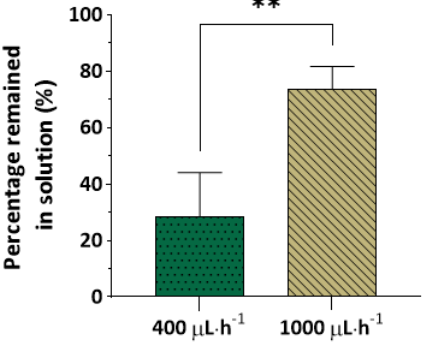
Figure 2. Relative concentration ratio (expressed as a percentage) of 1 µM Nile red in ethanol/PBS (1:3 v / v ) that remained in solution following continuous flow through PDMS microchannels at 400 µL∙h −1 or 1000 µL∙h −1 . Values show Mean ± SD from at least three independent measurements (** 𝑝 < 0.01 ).